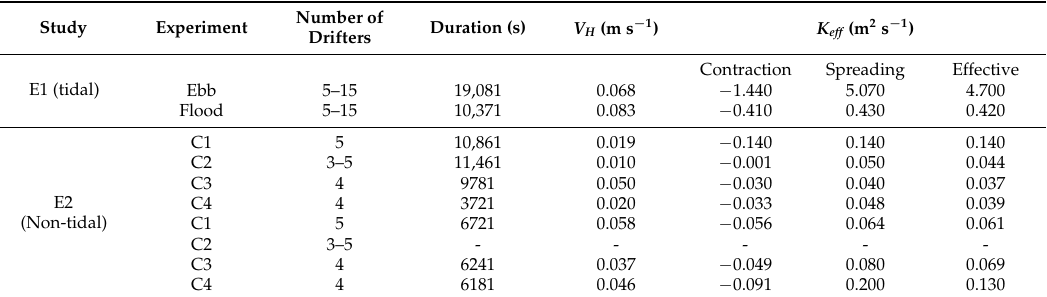
Table 2. Cluster dispersion coefficient during the open state (E1) and closed state